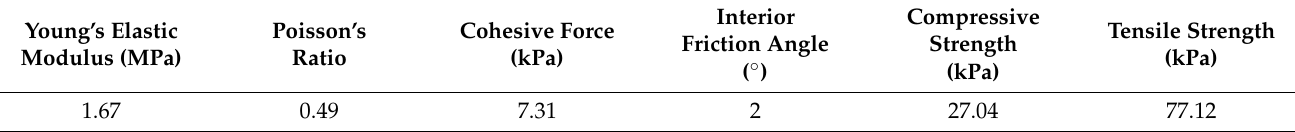
Table 2. Mechanical property parameters of seafloor sediment (note: the data was from